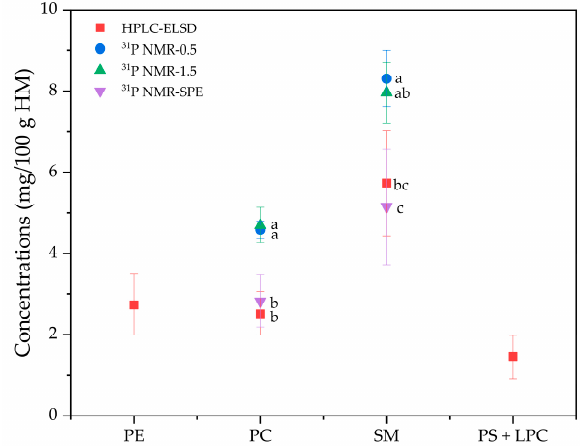
Figure 7. Comparison of the concentrations (mg/100 g HM) of phospholipid species. 31 P NMR-0.5, 31 P NMR analysis on 0.5 g of HM fat; 31 P NMR-1.5, 31 P NMR analysis on 1.5 g of HM fat; 31 P NMR-SPE, 31 P NMR analysis on HM fat applied to solid phase extraction (SPE); PE, phosphatidylethano- lamine; PC, phosphatidylcholine; SM, sphingomyelin; PS, phosphatidylserine; LPC, lysophosphati- dylcholine.